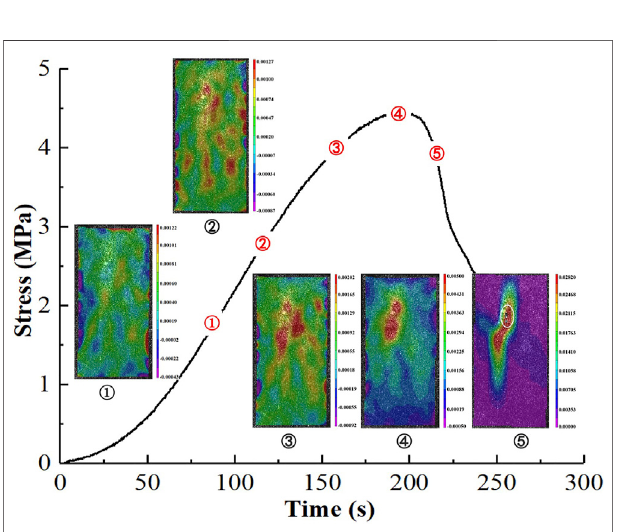
FIGURE 11 | The apparent strain fi eld of